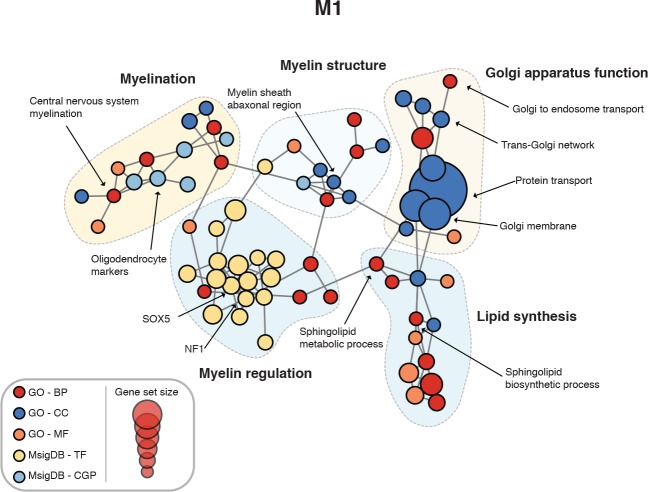
Enrichment map for human spinal cord module M1.